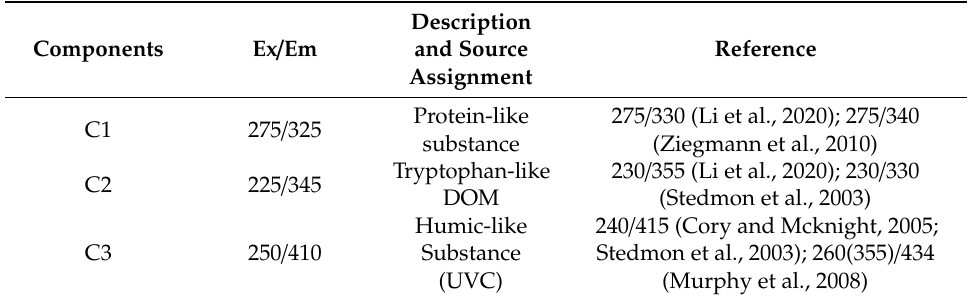
Table 2. Spectral characteristics of the three components identified by PARAFAC analysis in this study and their comparison with previously identified